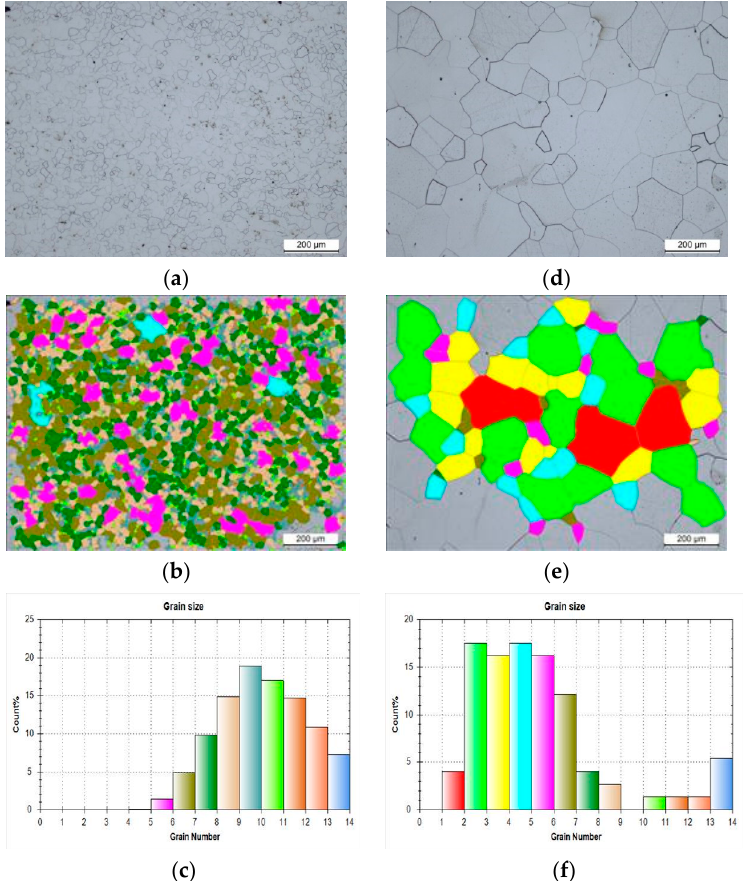
Figure 1. Microstructure and the histogram showing the grain size number distribution of 200 ( a – c ) and 300 steels ( d – f ). Table 2. Grain size analysis of the steels.